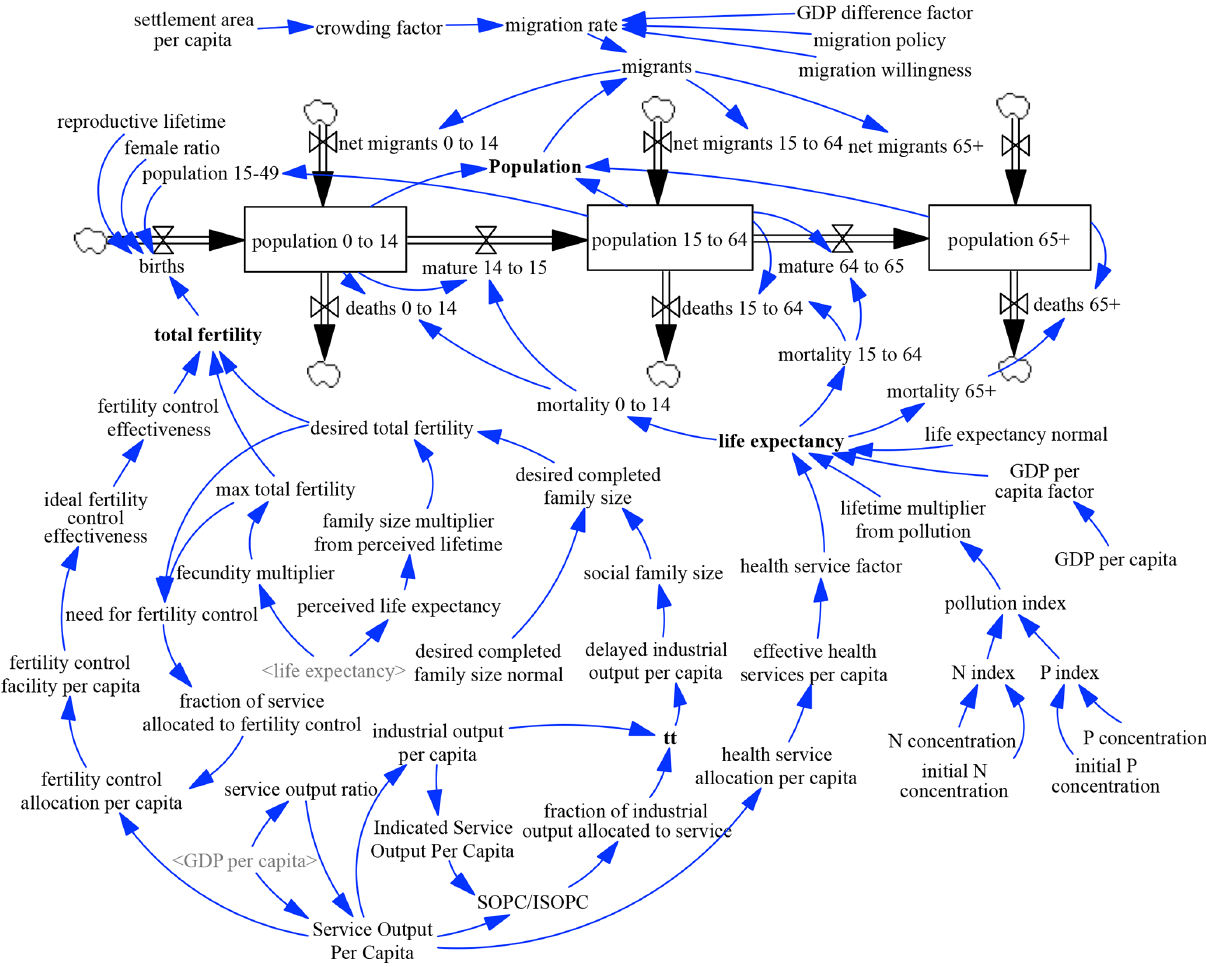
Figure 12. Stock and flow diagram of the population